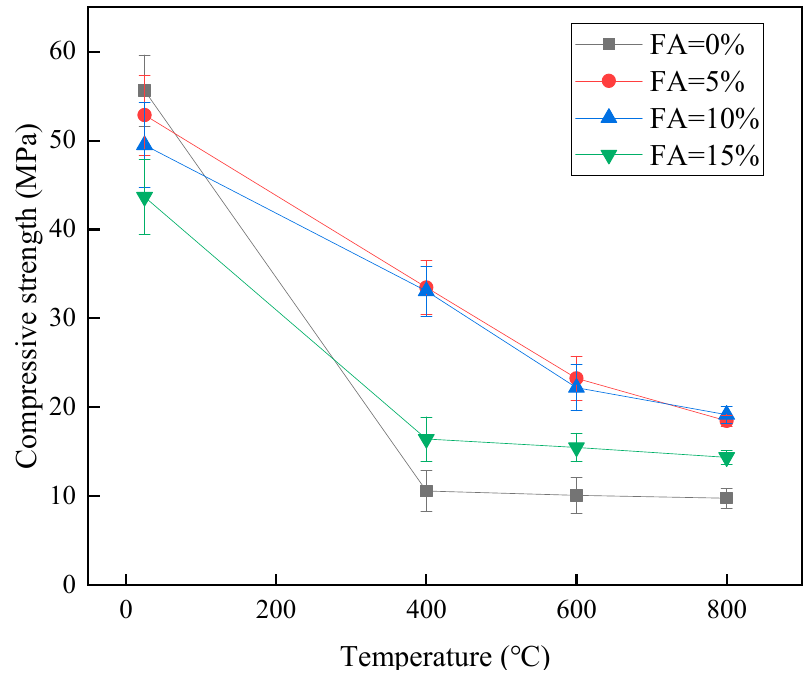
Figure 8. Compressive strength of 28 d specimens after high temperature (unit: MPa).